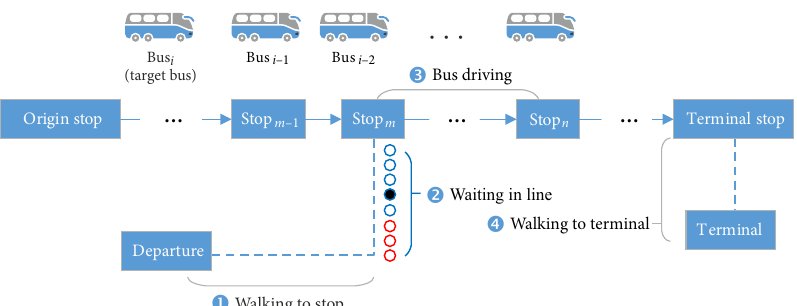
Figure 1. Overall process of bus